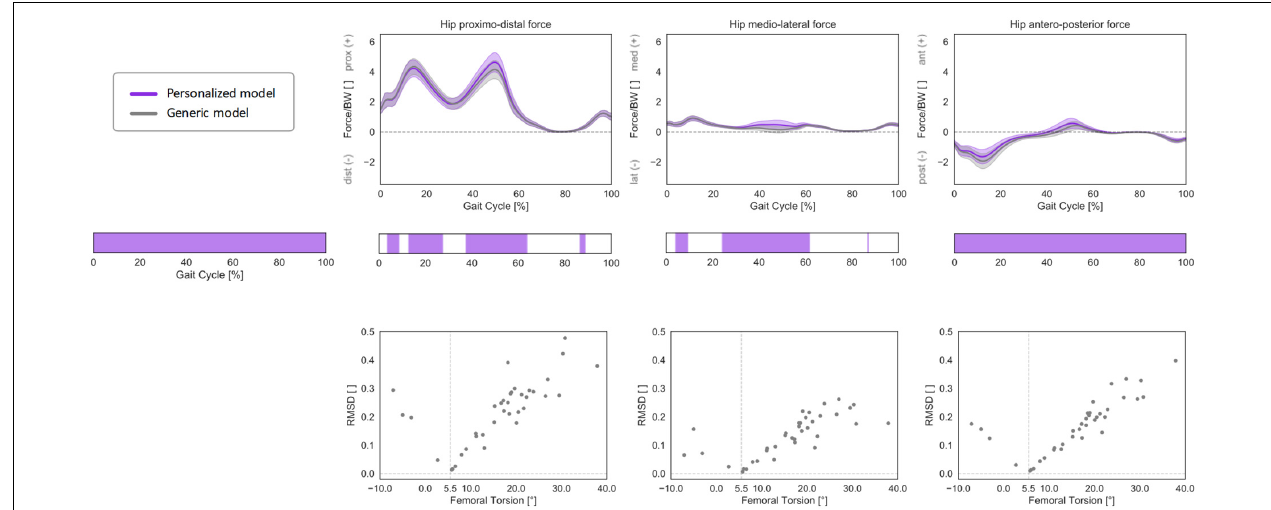
FIGURE 10 | 3D HCFs (mean ± standard deviation) over the GC computed with a generic, baseline musculoskeletal model (in gray) or with a personalized model accounting for subject-specific femoral torsion (in violet). HCFs were calculated in a proximal (pelvis-based) coordinate system according to ISB recommendations and are normalized by body weight (BW). Phases of GC in which a statistically significant correlation was observed in the SPM vectorial paired Hotelling T 2 are indicated in the leftmost panel. Below each force component, the results of the post hoc scalar-field paired t -tests are reported. Root mean standard deviation between the HCFs predicted with the two different models was calculated for each subject and plotted against subject-specific femoral torsion values. The torsional value of the baseline model geometry (5.5 ◦ ) is reported as a dashed vertical line. Positive values indicate antetorsion, negative